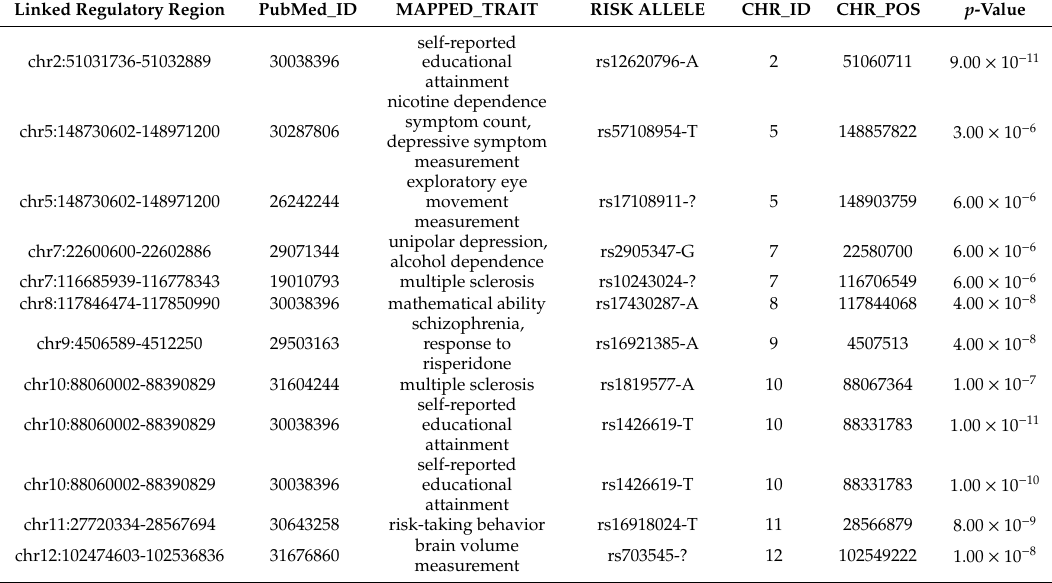
Figure 5. Genomic variants found within top regions. The first four box and whisker plots are based on gnomADv3 whole genome extraction and the last based on all rsID listed variants. All values are the number of variants mapped per base pairs (bp) of element. Outliers are labeled based on GeneHancer connected gene. The four gnomADv3 plots show all variants (far left) followed by cutoffs for allele frequency within all populations (cutoffs for 0.001, 0.01, and 0.1). Table 1. Neurological linked GWAS to regulated enhancers. All SNPs found within identified enhancers in addition to all population linked 0.8R 2 SNPs were queried within the GWAS catalog obtained on8 / 23 / 2020. In red text is a SNP linked to the highlighted region in Figure 2C. CHR = chromosome, POS =